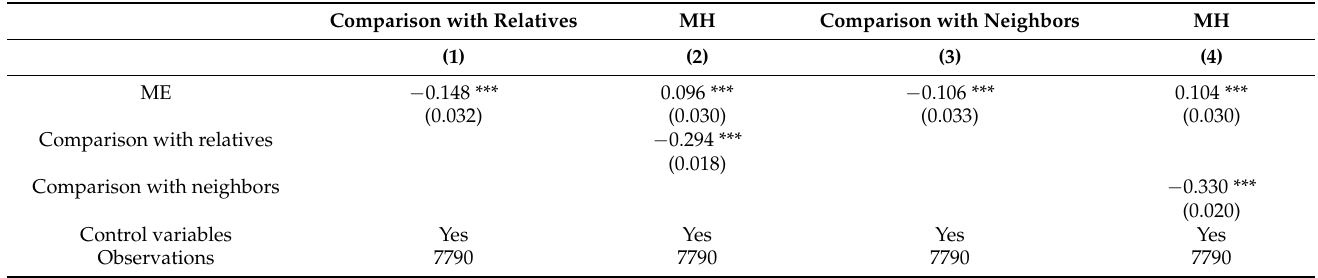
Table 5. Mechanism analysis: social